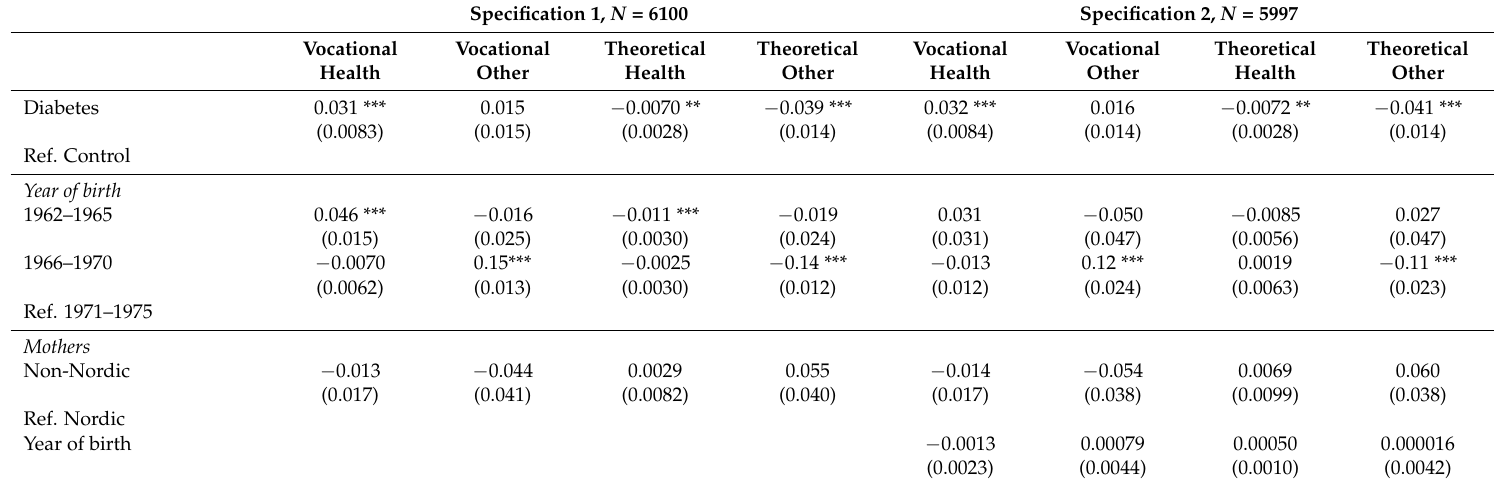
Table 4. Average marginal effects of men’s probability of having different fields of upper secondary